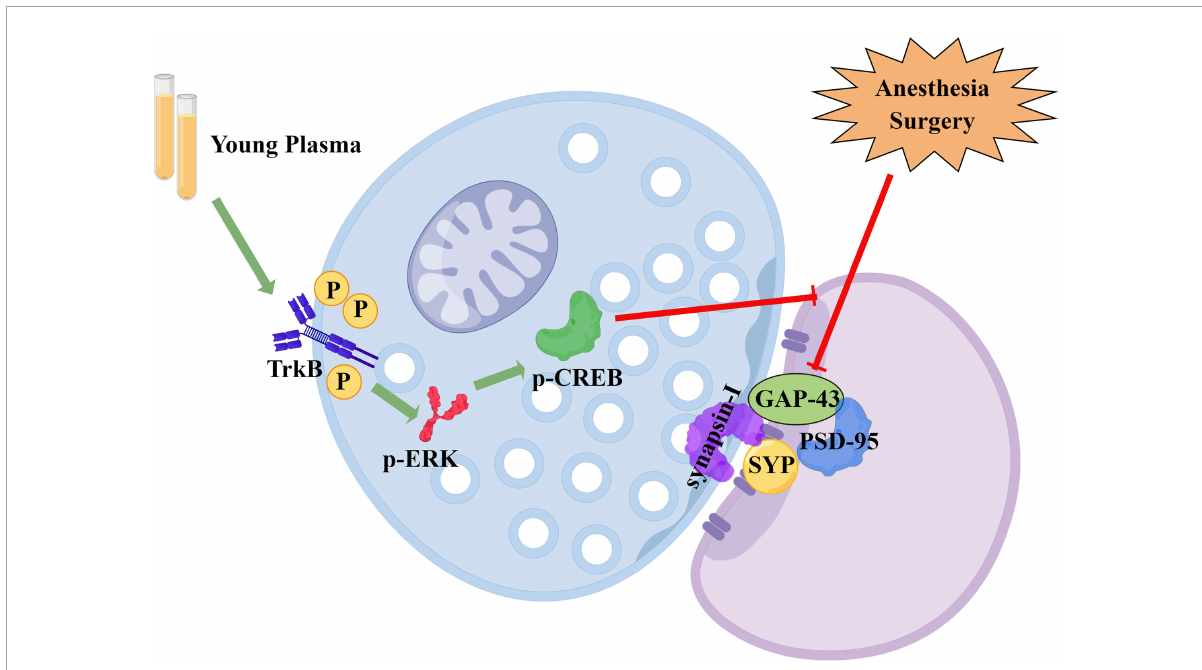
FIGURE9 Schematic diagram of the neuroprotective effect of young plasma (Drawn by Figdraw platform, ID:WARIWa686f). Young plasma improves synaptic plasticity by activating TrkB/ERK/CREB signaling pathway, thereby inhibiting cognitive impairment caused by surgery and